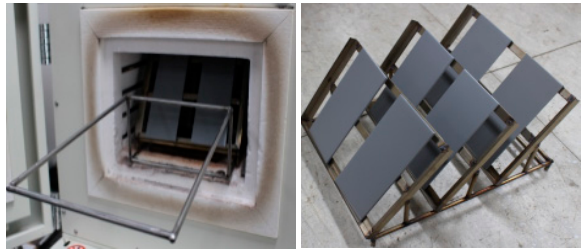
Figure 2. Experimental test setup for the electric furnace heating